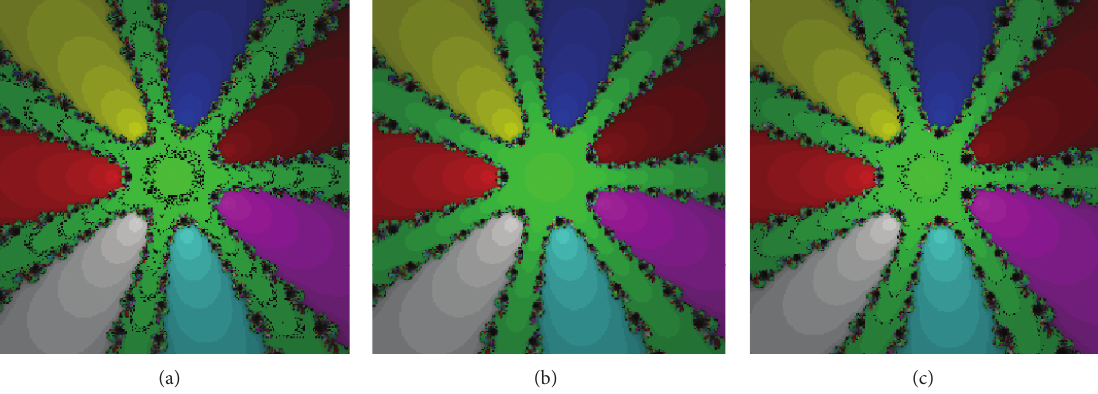
Figure 5: The basins of attraction for CM 1 4 (a), KM 4 (b), and MKM 4 (c) in problem 3.